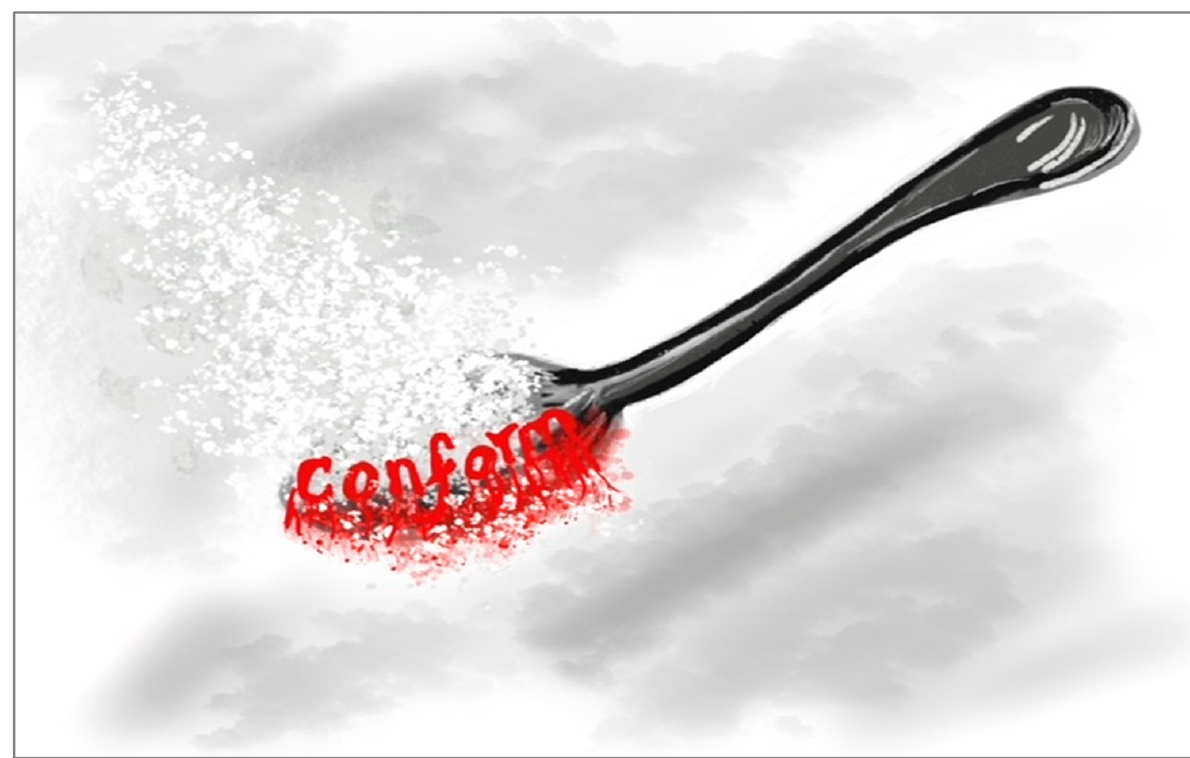
Figure 3. A spoonful of sugar”. The ‘medicine’ and scientific-medical dose of ‘parenting profession- alisation’.